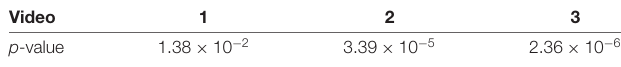
TABLE 5 | The Mann-Whitney U test results of three videos. Video 1 2